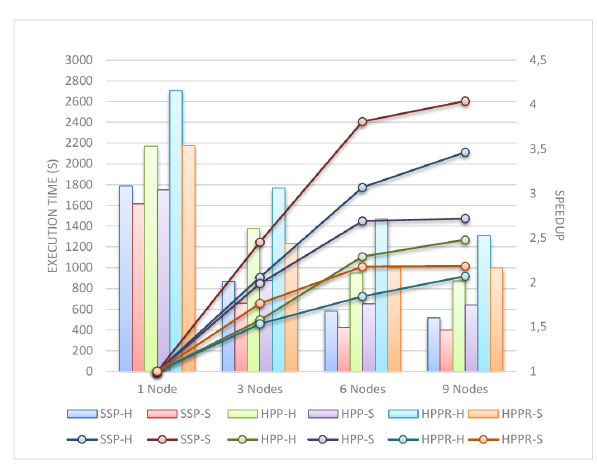
Figure 3. Segmentation of the 8K image.